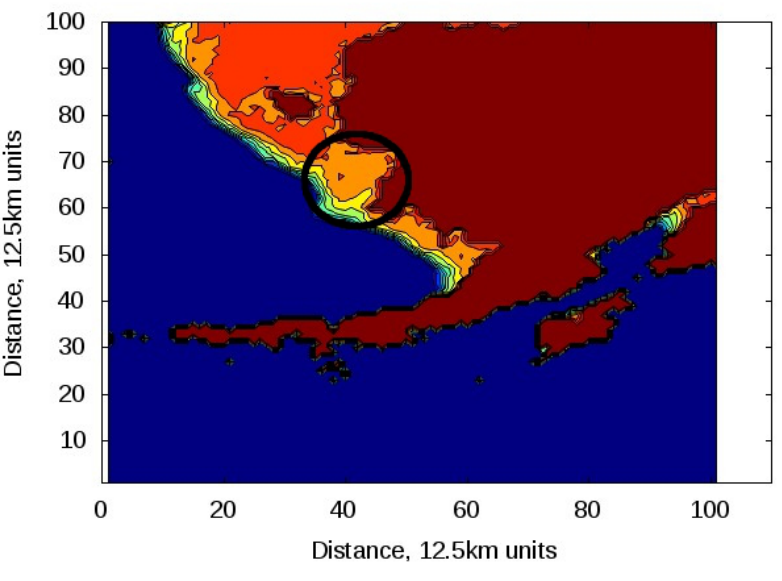
Figure 2. Data from the AMSR-E instrument on the Aqua satellite for February 4, 2005. Including total ice concentration over the collection region. The greater collection region is circled in black, where the reflection moved over areas of ice concentration between 96 and 91 percent. Dark blue represents ocean, increasing ice concentration changes from blue to dark orange and land is shown in brown. The National Ice Center charts indicated the entire collection interval was from 90 to 100 percent